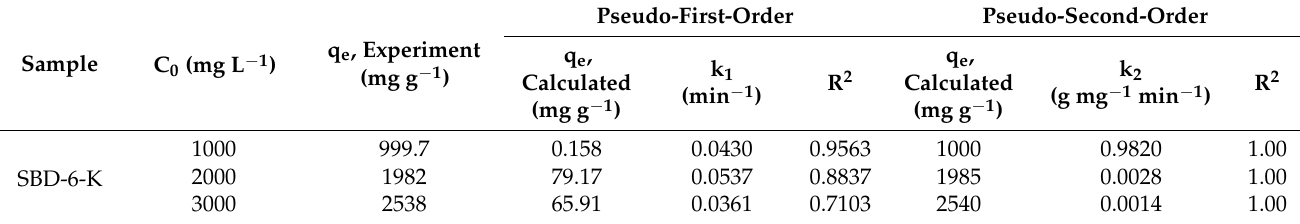
Table 3. Kinetic model parameters for the adsorption of MB onto SDB-6-K at different dye concentrations.